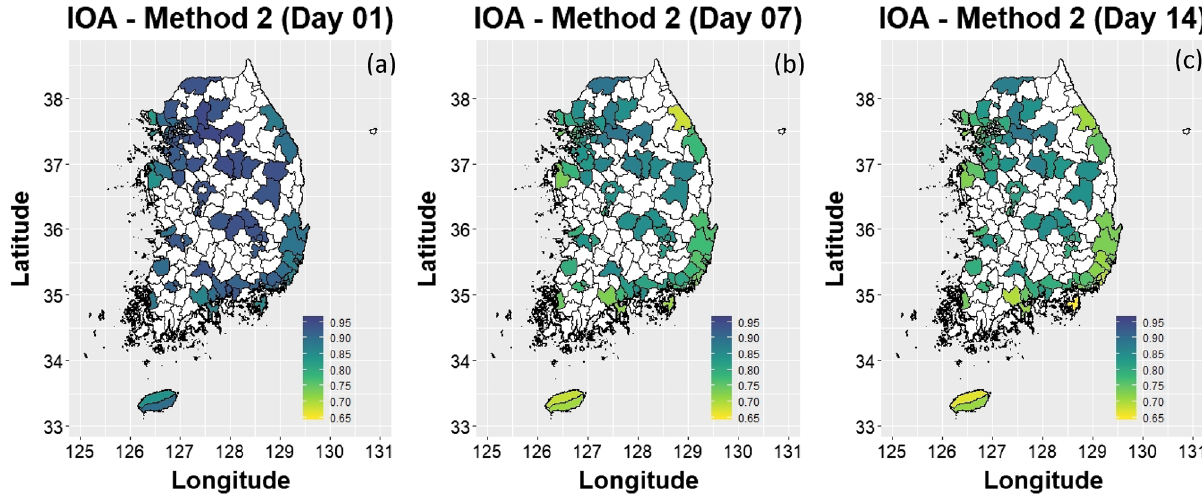
Figure 2. Average IOA all stations (CNN-method 2) in each district of South Korea. ( a ) IOA for Day 1; ( b ) IOA for Day 7; and ( c ) IOA for Day 14. (Figures are created using R ggplot2 27 : https:// ggplo t2. tidyv erse.